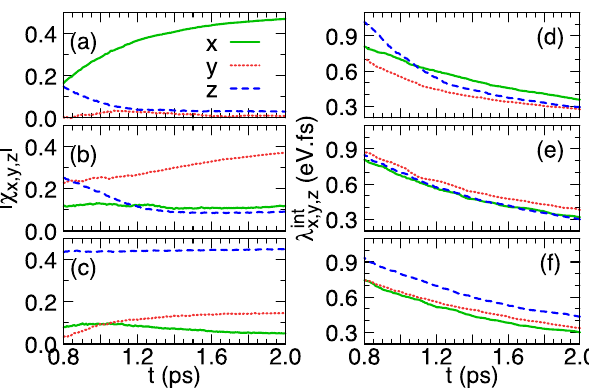
Fig. 4 Correlation between the components of vector chirality χ and integrated chiral spin mixing interaction strength λ int for different initial con fi guration. a – c Show the evolution of components of χ and d – f show the corresponding evolution of λ int for three different initial con fi gurations. a , d Correspond the con fi guration considered in Figs. 1, 2. b , e and c , f Show the correlation for two other initial con fi gurations . The green, blue and red lines in a – c show the magnitude of χ x , y , z and in d – f they show the values of λ int x ; y ; z